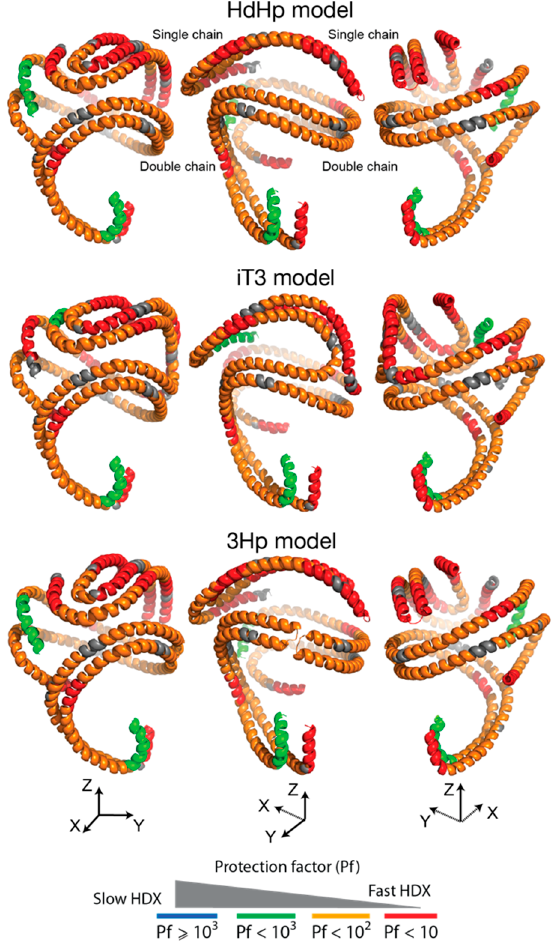
Figure 7. The pattern of HDX protection factors for apoA-I domains in rsHDL (corresponding to digested peptides) mapped on rsHDL models obtained from small-angle neutron scattering: the helical dimer hairpin monomer (HdHp) model (top), the integrated trimer (iT3) model (middle), and the three hairpin monomers (3Hp) model (bottom). The 3D HDX maps show that overall the apoA-I hairpin monomer was more dynamic than the apoA-I helical dimer.